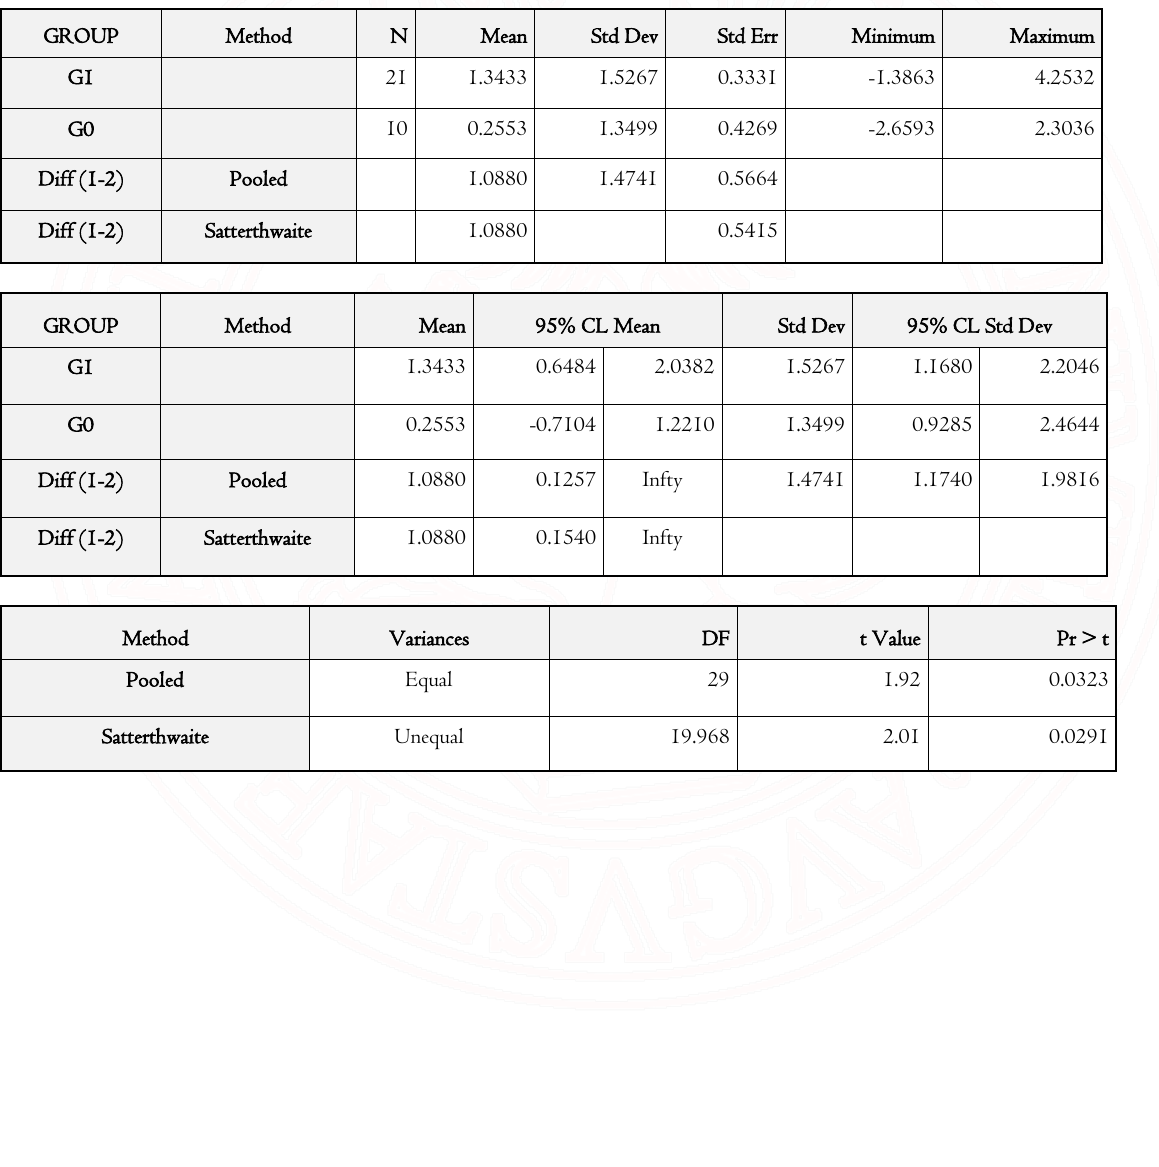
Table IV. Mean LOG_IFCI of Group1 (moderate & higher yields) vs. Mean LOG_IFCI of Group 0 (low yields)